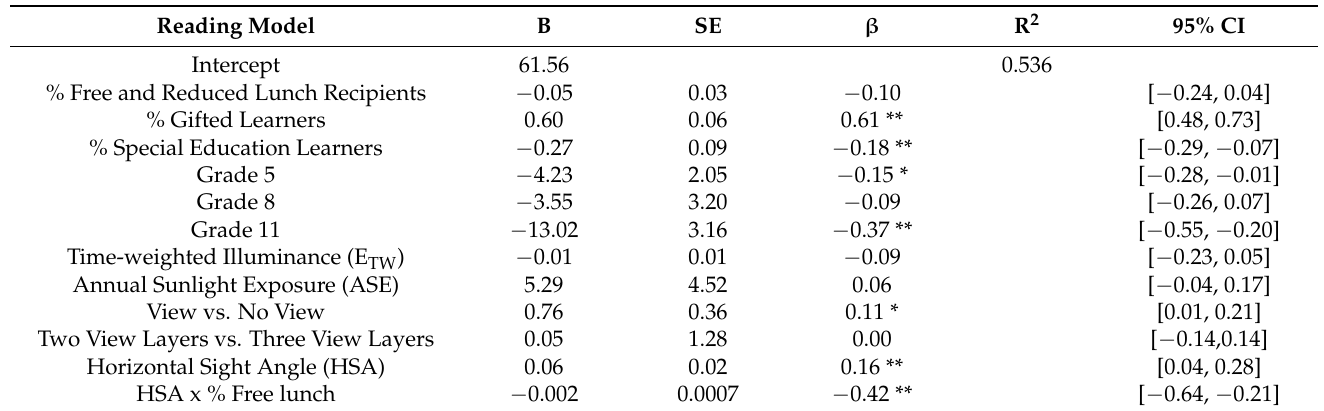
Table 3. Multivariate Regression of Reading on Demographics and Lighting Metrics.